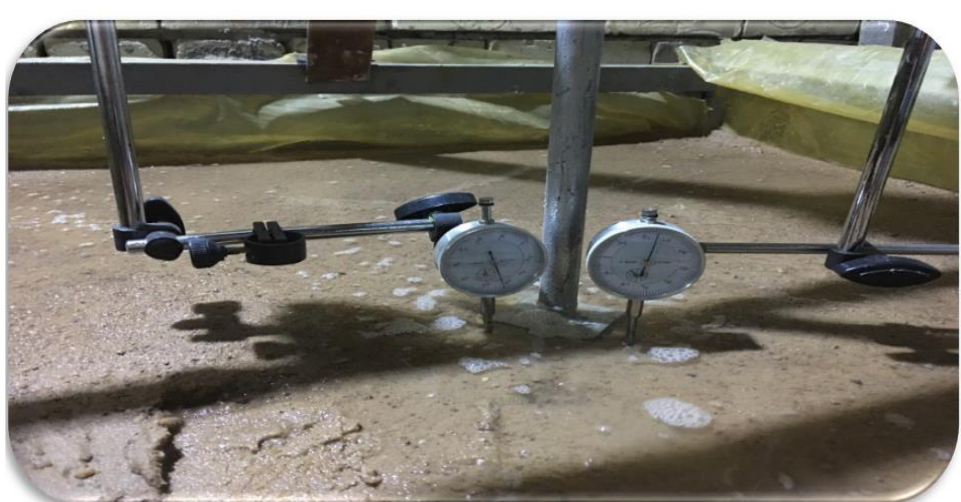
Fig. 6. Natural soil failure shape tested in model.